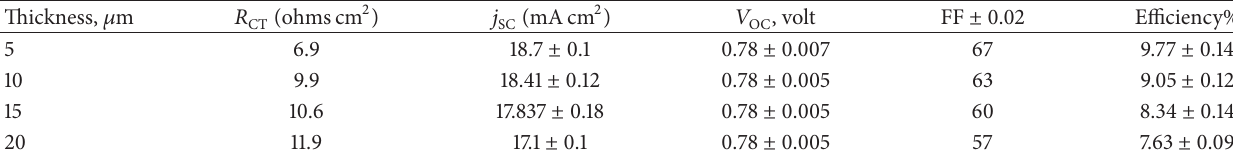
Table 6: DSSC parameters as a function of counter electrode